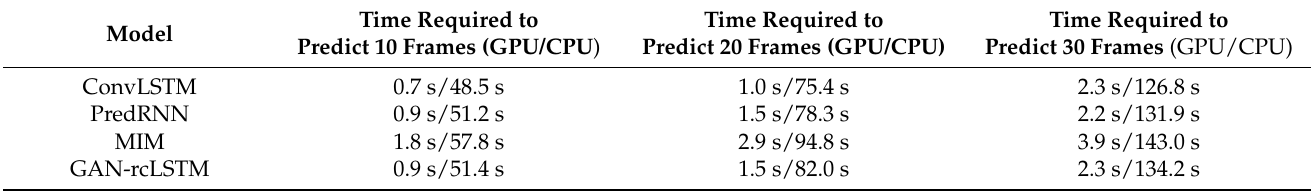
Table 6. Time consumed for different models to make predictions. Each pair of numbers represents the time spent using GPU acceleration and using only the CPU. The statistical results are from the average time-consuming of 20 runs, in